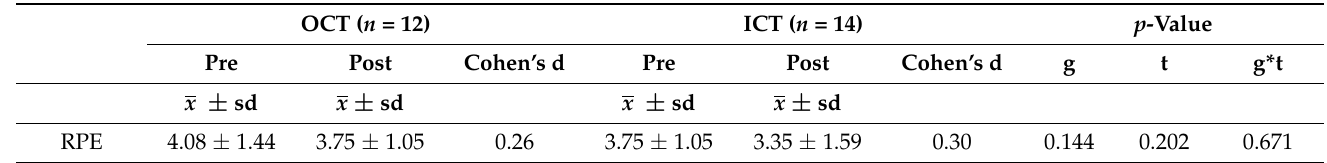
Table 3. Rating Perception Effort of the outdoor and indoor training groups before and after nine weeks of training ( n =